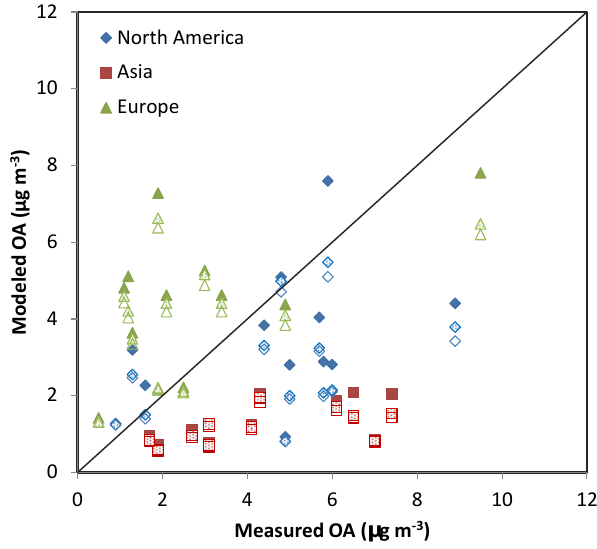
Fig. 6. Modeled vs. measured OA mass concentrations at several Fig 6: Modeled vs. measured organic aerosol (OA) mass concentrations at several locations in 4 locations in North America, Europe and Asia. The solid fill repre- North America, Europe and Asia. The solid fill represents MZ4-C2, patterned fill represents 5 sents MZ4-C2, patterned fill represents MZ4-C1, and no fill repre- MZ4-C1, and no fill represents MZ4 base-case simulations. Measured data were adapted from 6 sents MZ4 base-case simulations. Measured data were adapted from Zhang et al. (2007). 7 Zhang et al.